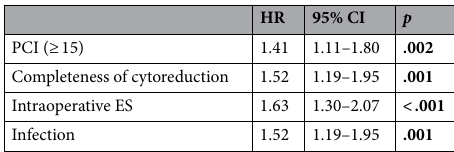
Table 5. Independent prognostic factors in Cox-regression analysis. Significant values are in